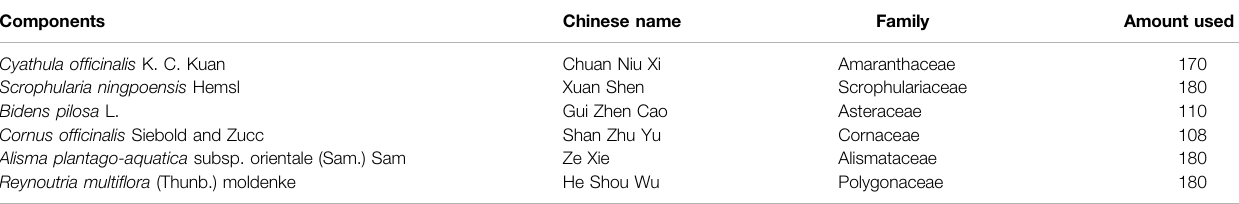
TABLE 1 | The components of Qian Yang Yu Yin. Components